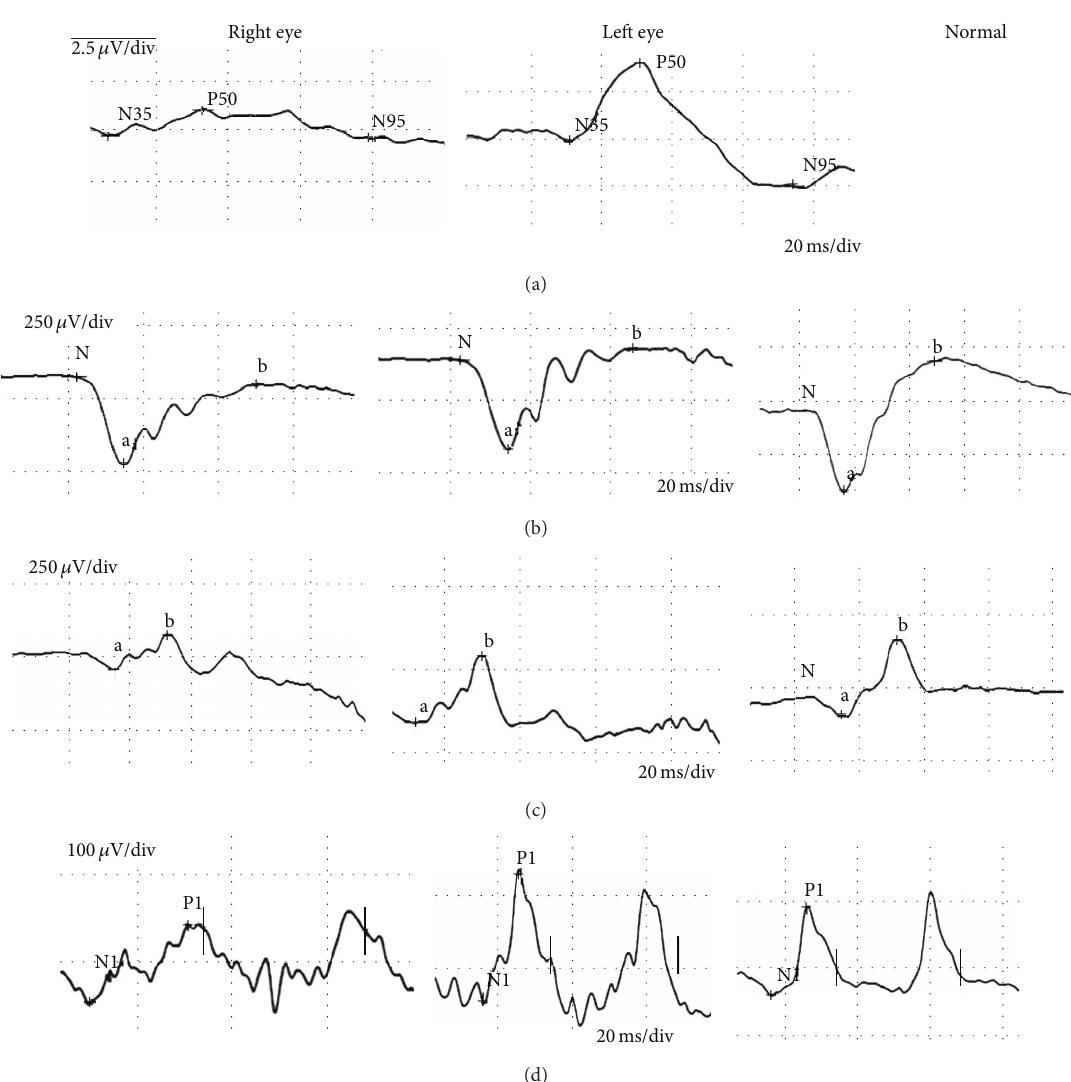
Figure 3: (a) Pattern electroretinogram (PERG) showing reduction of the P50 amplitude in the right eye. (b) Bright flash dark adapted ERGs (DA 11.0) demonstrating a “negative” ERG in the right eye, as b-wave is of a lower amplitude than a-wave. (c) Photopic single flash ERGs (LA 3.0) responses were subnormal in the right eye. (d) Light adapted 30Hz flicker ERG (LA 30 Hz) demonstrating implicit time delay in the right